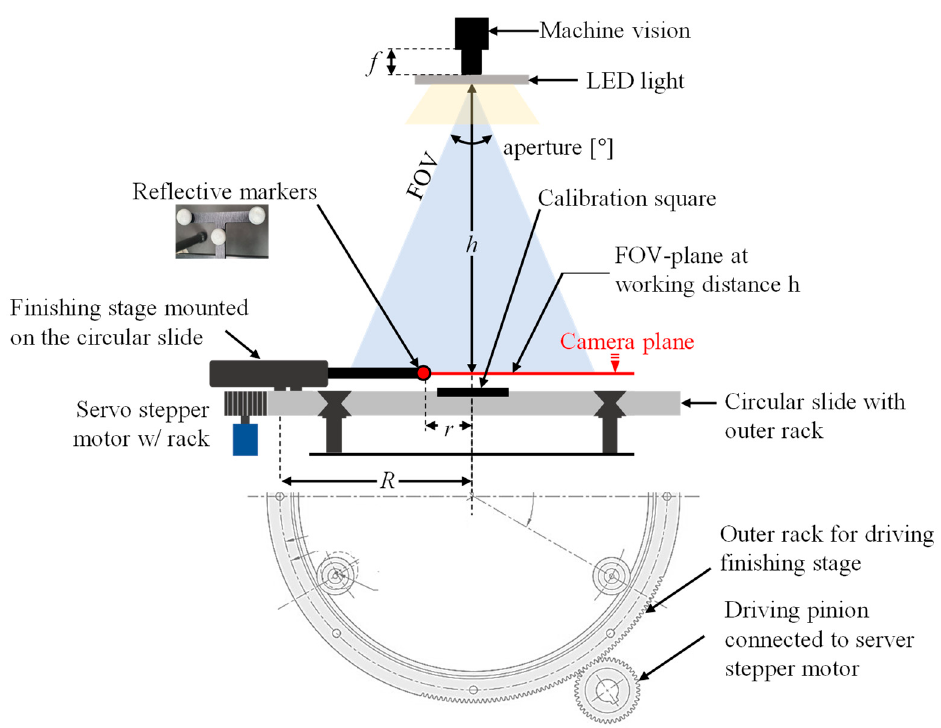
Figure 8. Schematic of the entire measurement system. Table 1. Information about all the hardware and software used in this study.